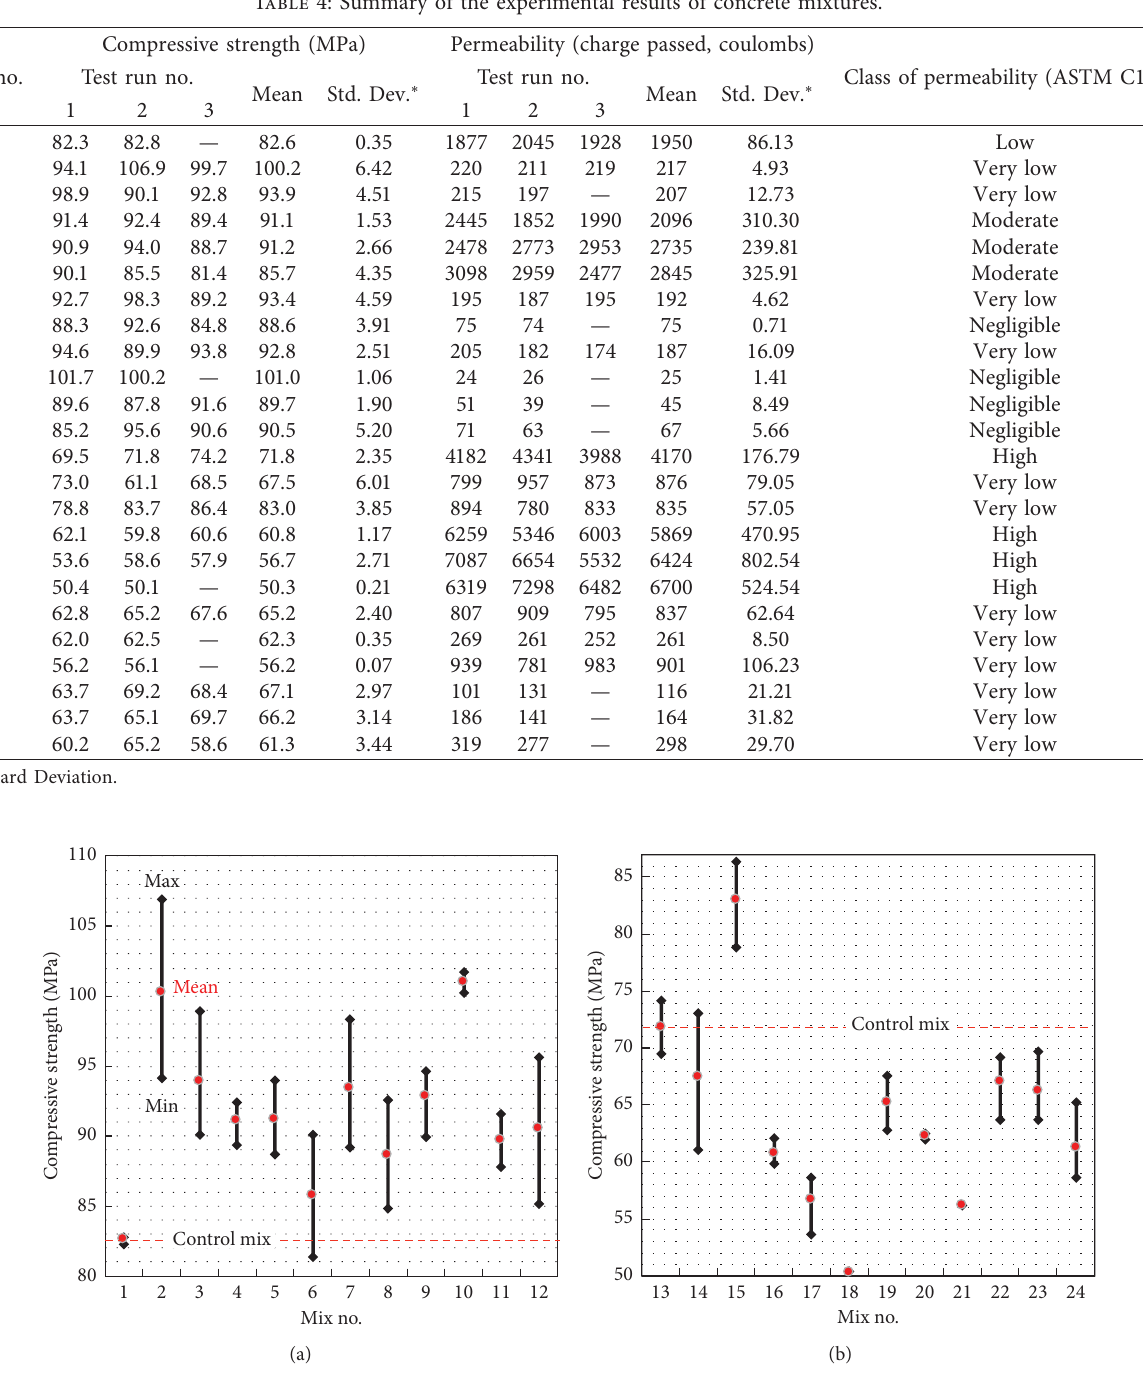
Figure 3: Observed compressive strength ranges of concrete mixtures that incorporate SF and NP: (a) ( w / b ) � 0.25 (b) ( w / b ) �